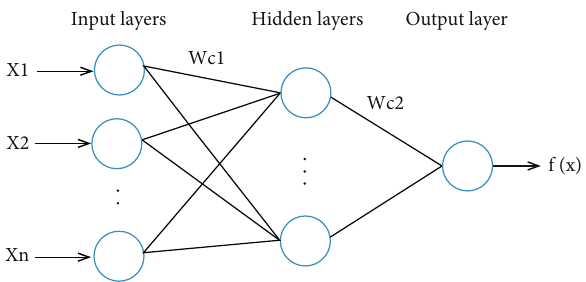
Figure 9: Schematic diagram of neural